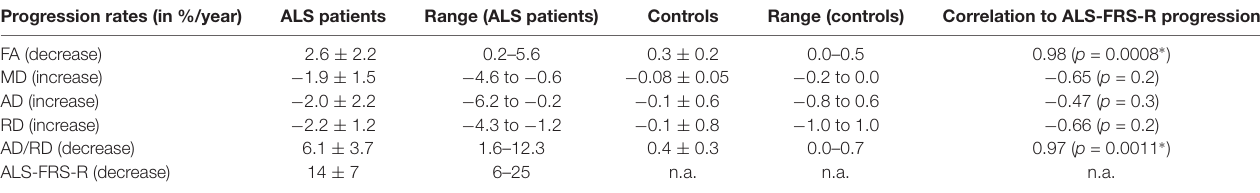
TABLE 3 | Arithmetically averaged progression rates (in %/year) for ALS patients and controls (mean ± standard deviation) for DTI metrics—axial diffusivity (AD), fractional anisotropy (FA), mean diffusivity (MD), radial diffusivity (RD) and AD/RD. Progression rates (in